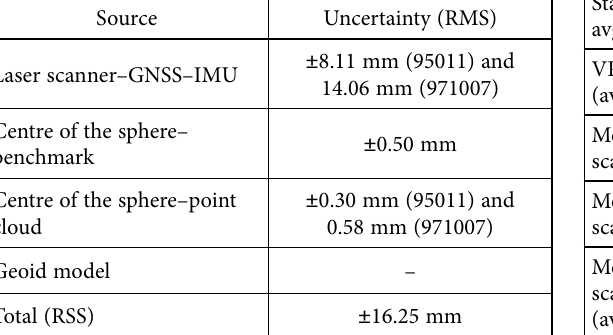
Table 8. Measurement uncertainties of the MLS